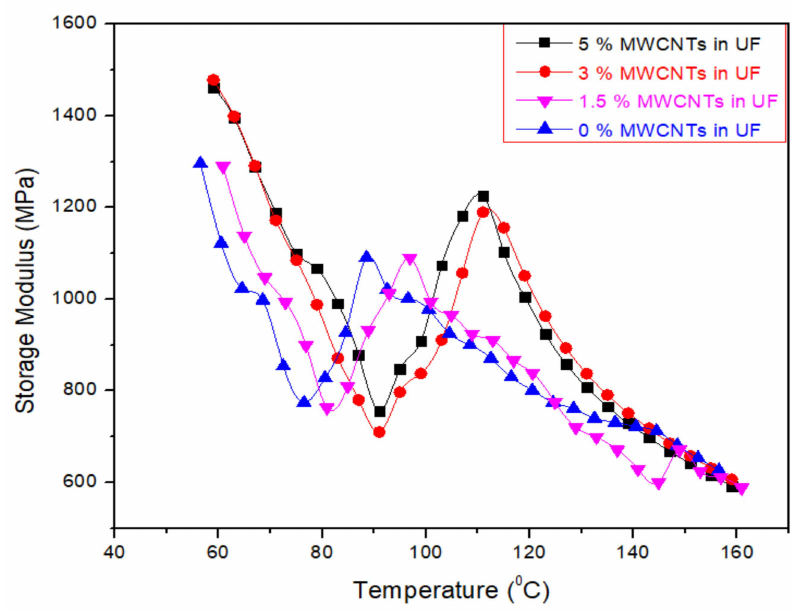
Figure 5. DMA analysis (storage modulus) of UF resin with and without MWCNTs. As the viscosity of the nanofillers increases with the addition of MWCNTs, the gelling occurs early and ultimately increased the storage modulus and tan delta values. The gel time was achieved for 0%, 1.5%, 3.0% and 5% MWCNTs at 87 ◦ C, 87 ◦ C, 96 ◦ C, 110 ◦